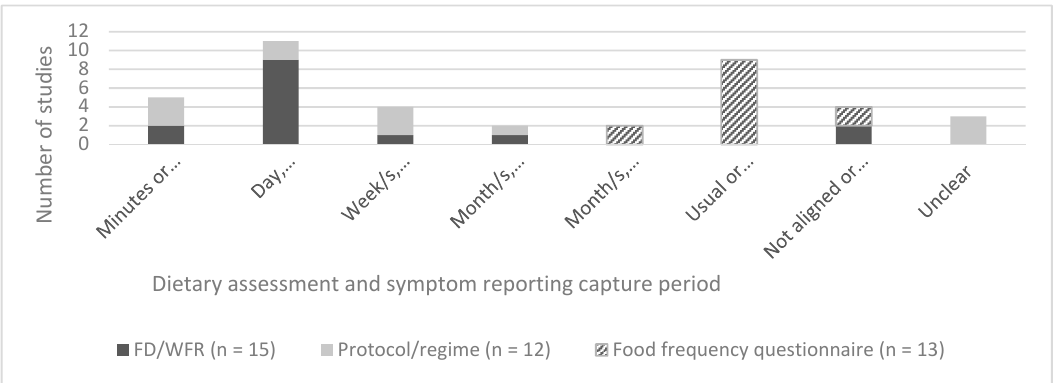
Figure 4. Alignment between dietary assessment and the symptom-reporting capture period in studies that assessed relationships between dietary intake and FGID symptoms. Nutrients 2019 , 11 , x FOR PEER REVIEW